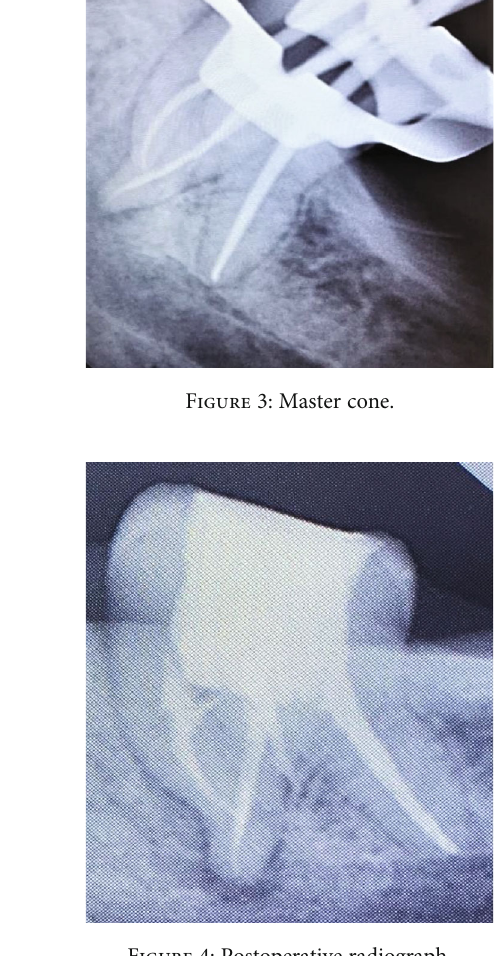
Figure 4: Postoperative radiograph.